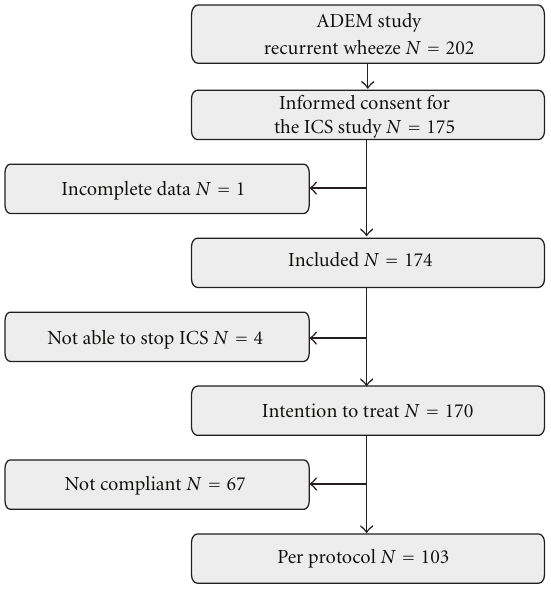
Figure 1: Study flow chart.